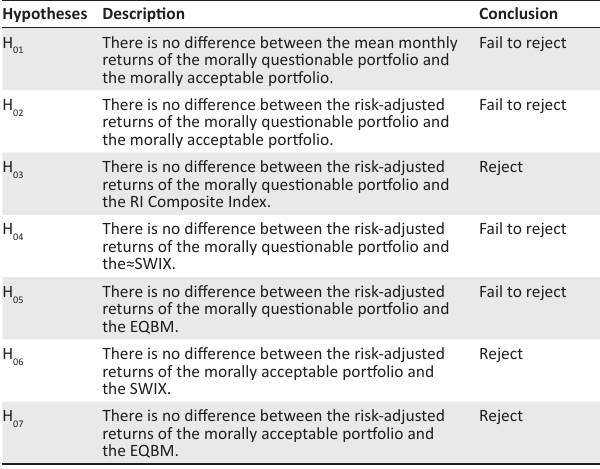
TABLE 7: Addressing the research